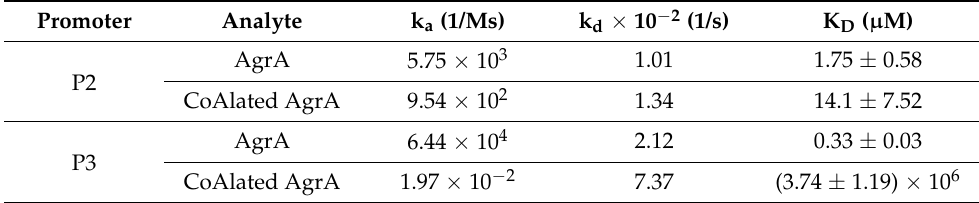
Table 1. Interaction parameters of CoAlated AgrA to P2 and P3